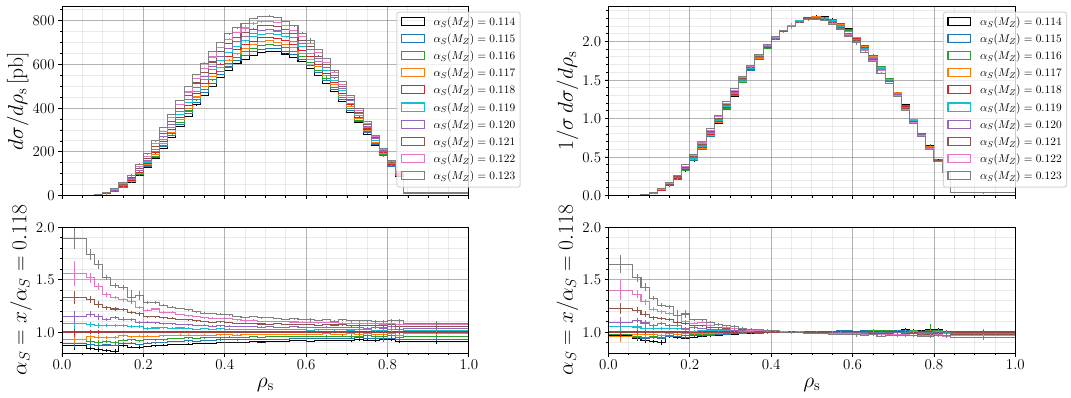
Figure 26 . Predictions for the ρ s (left) and R ( m t , ρ s ) (right) distributions in a full NLO com- putation with scale µ 0 = H B / 2 , using different α S ( M Z ) + PDF values, as extracted in the NLO T ABMP16 α S ( M Z ) + PDF fits. Two-loop α s evolution is considered. The top-quark mass value m t is fixed to 172.5 GeV for all curves. In the lower inset, the ratio of predictions using different α s ( M Z ) + PDF values with respect to the case where α s ( M Z ) = 0 . 118 is